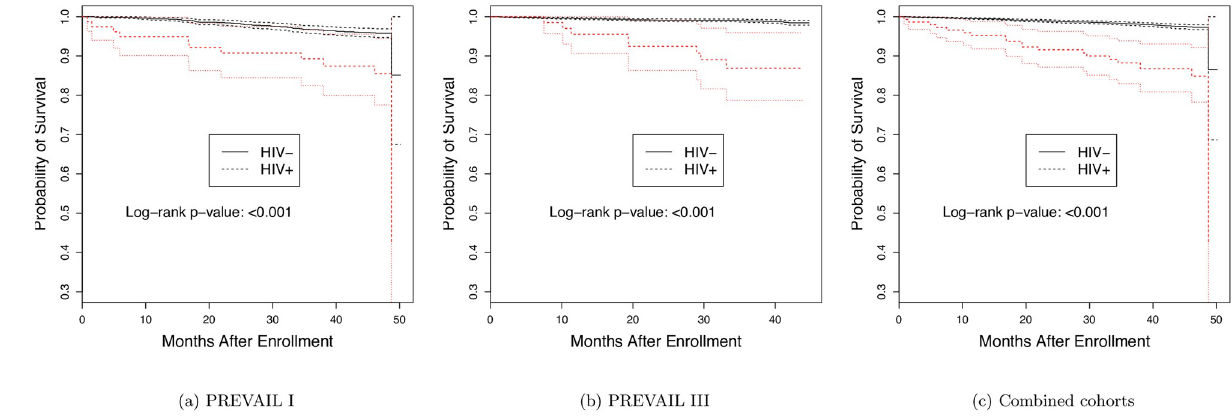
Fig 1. Probability of survival over time by baseline HIV